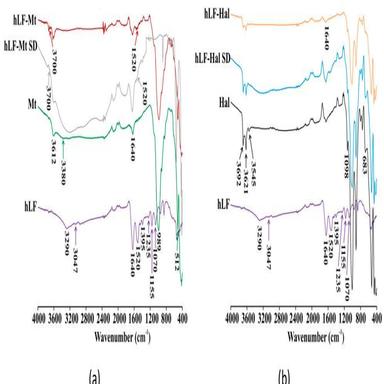
FTIR spectra of nanohybrids and pristine components: (a) Mt-based nanohybrids; (b) Hal-based nanohybrids.